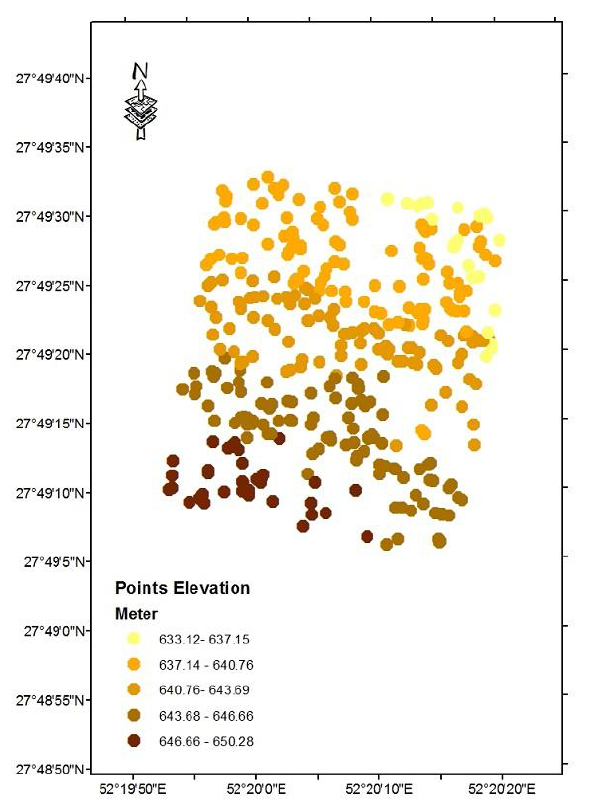
Figure 3. Matched Points Height extracted by proposed method in this paper